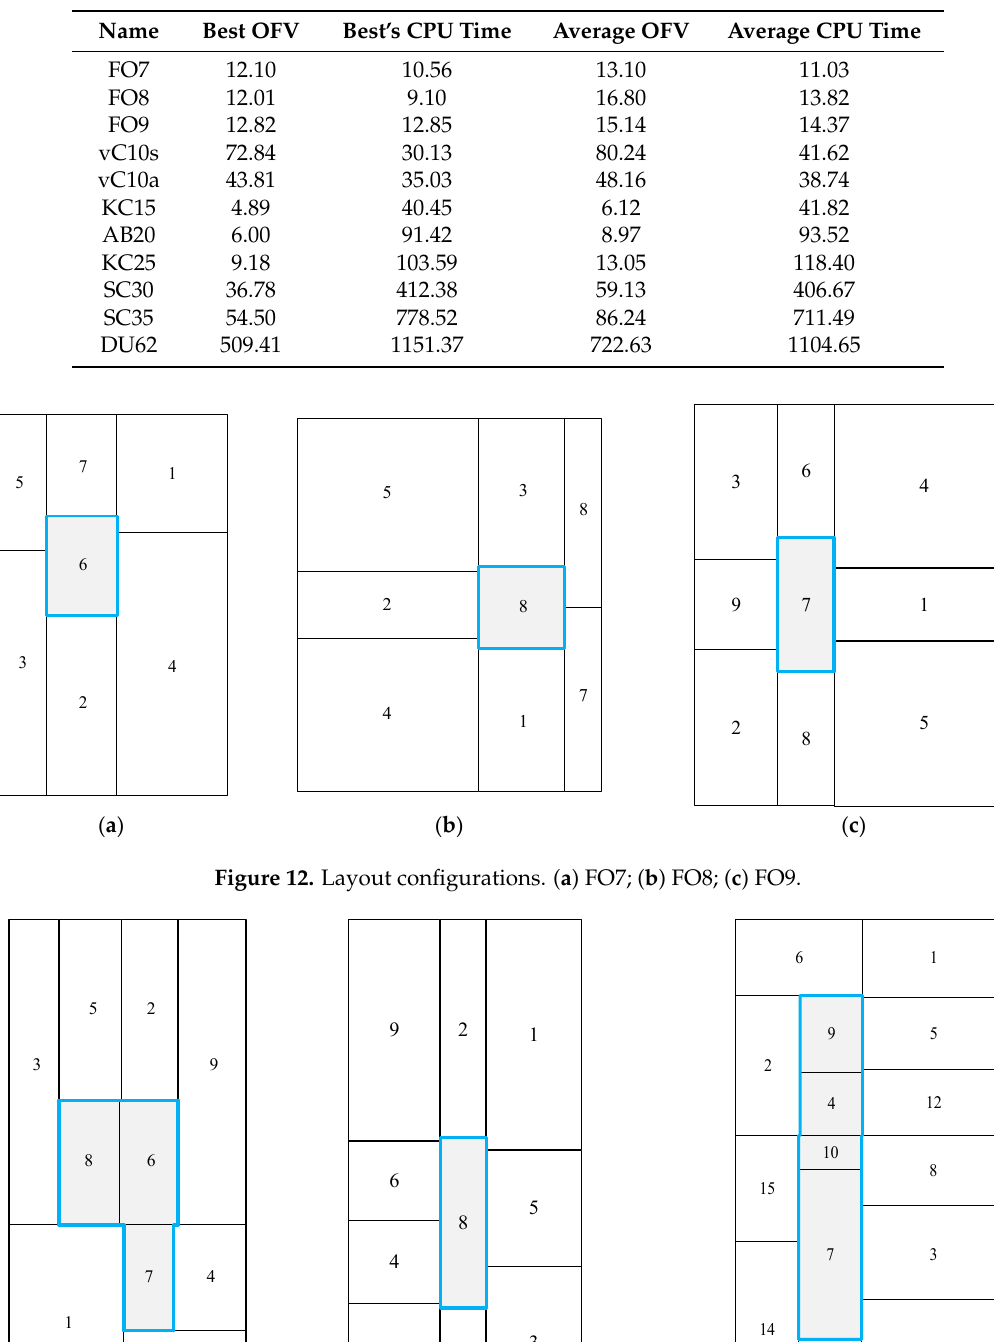
Table 4. The experiment results.